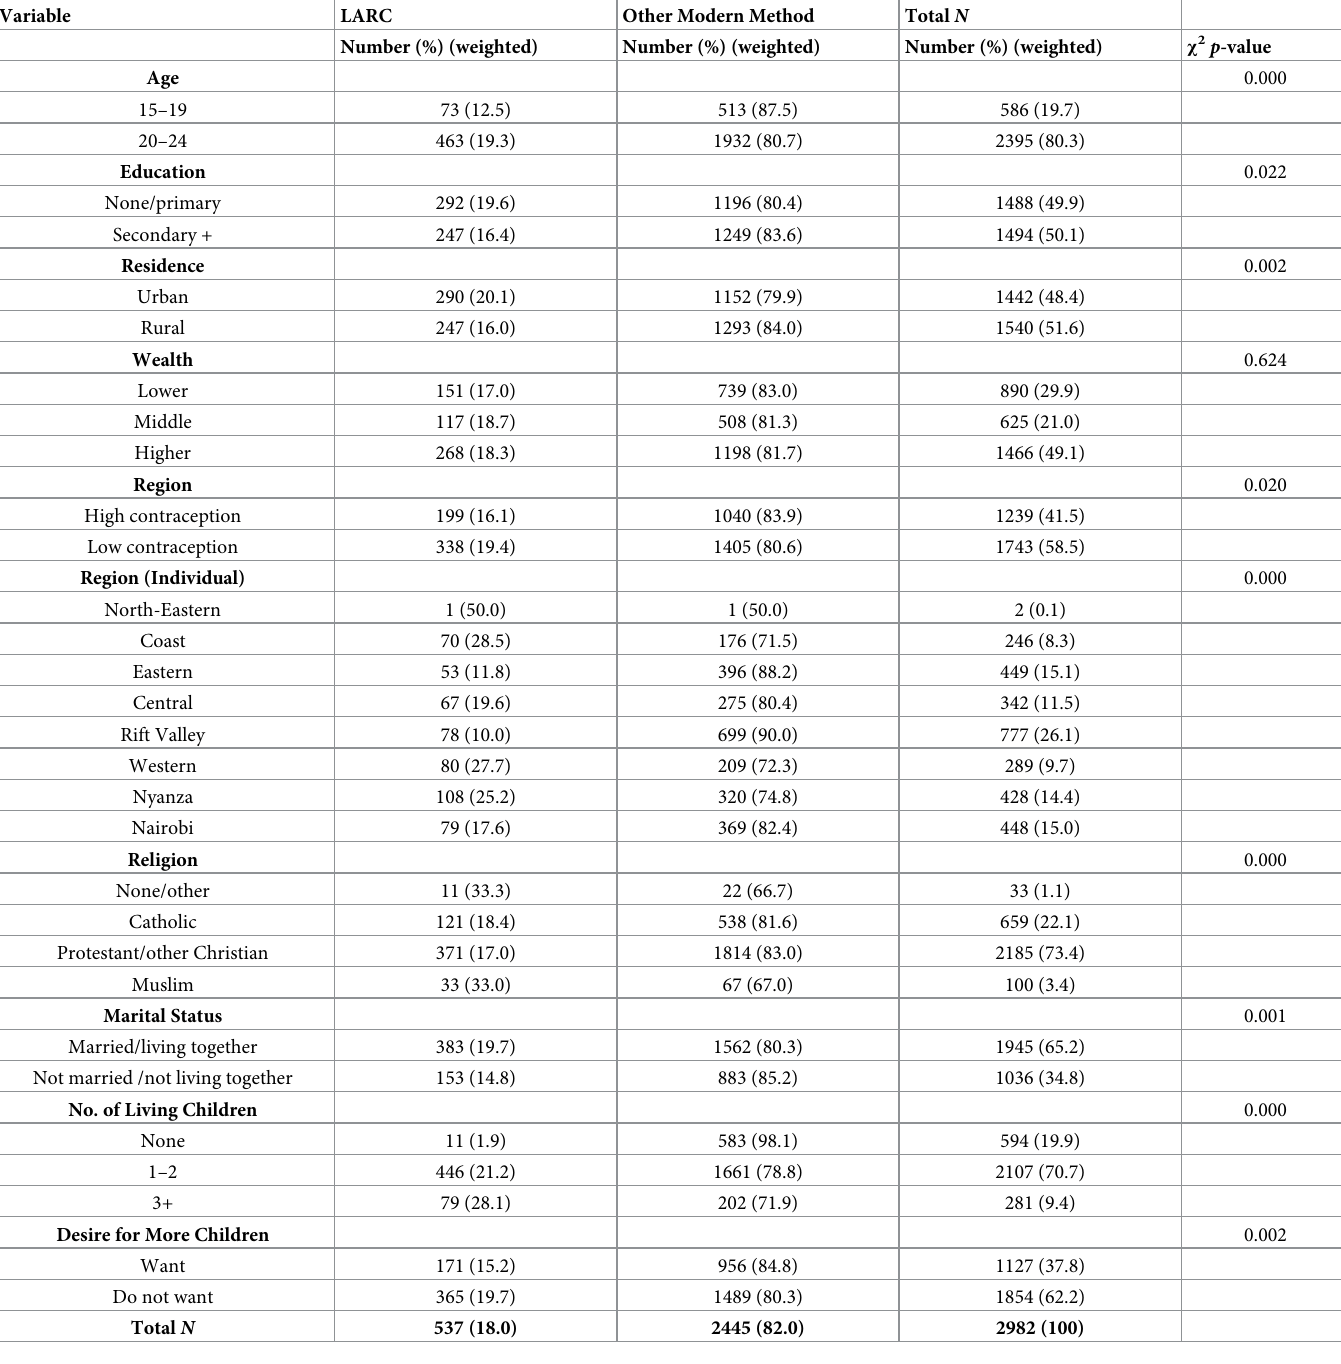
Table 2. Differentials of LARC use for women aged 15–24 in Kenya, 2014 via background characteristics.